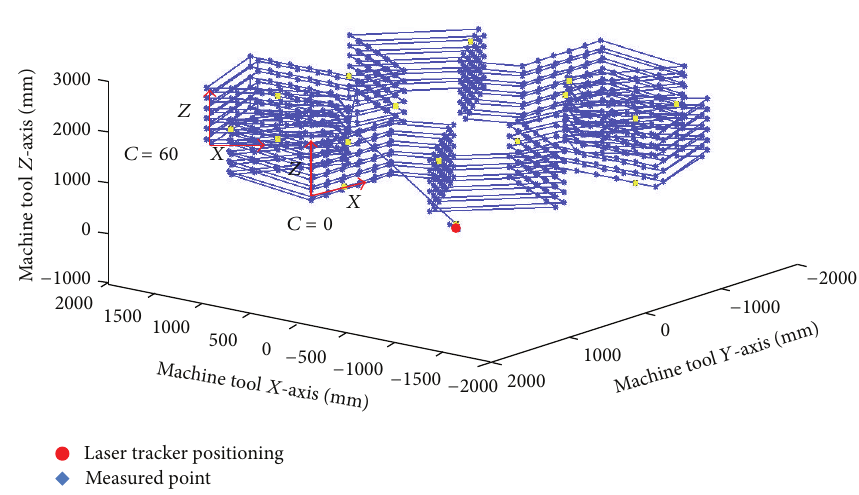
Figure 7: Discretization of the machine tool work space. Joint characterization of